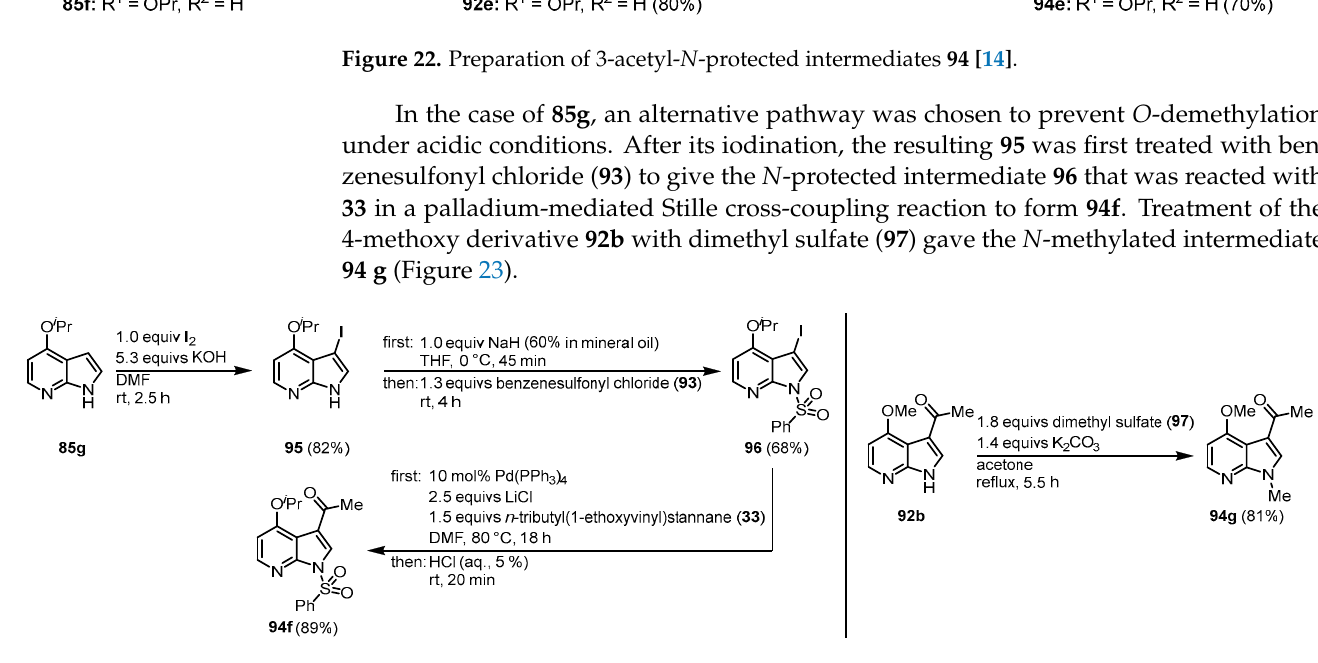
Figure 23. Alternative pathways to access 94f and 94g [14].